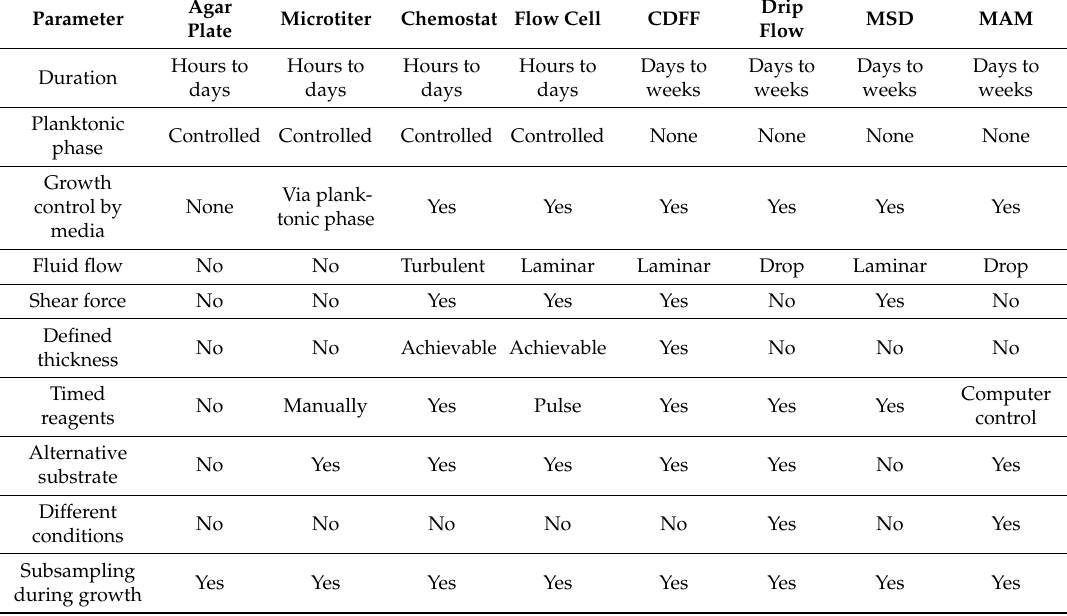
Table 1. Characteristics of common microbial culture models for cariology